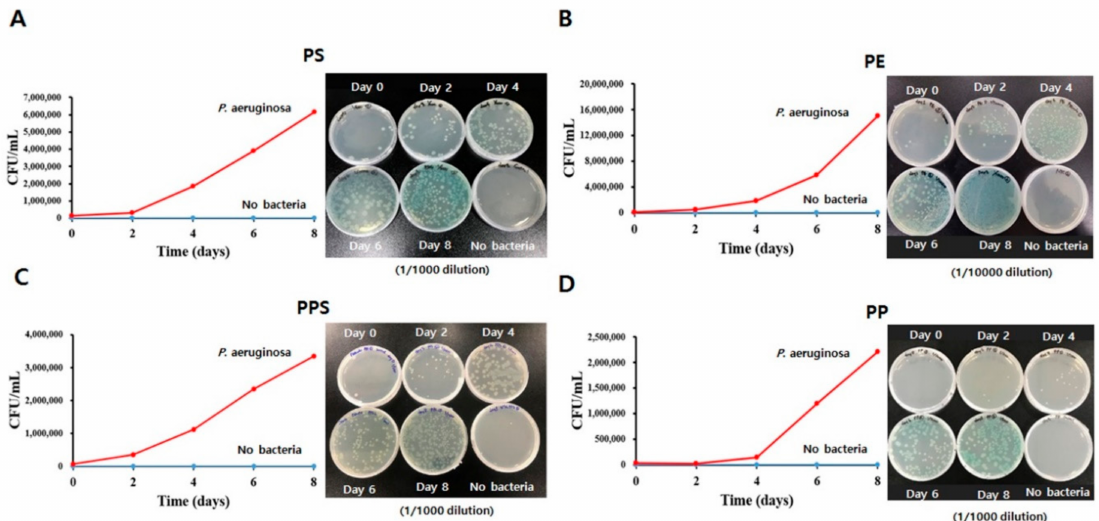
Figure 6. Comparison of growth rate of Pseudomonas aeruginosa when supplied with PS, PE, PPS or PP as the sole carbon source. Graph (left) and plates (right) of counted colony-forming units (CFU) of P. aeruginosa in liquid LCFBM supplied with 1 g of PS ( A ), PE ( B ), PPS ( C ) or PP ( D ) for eight